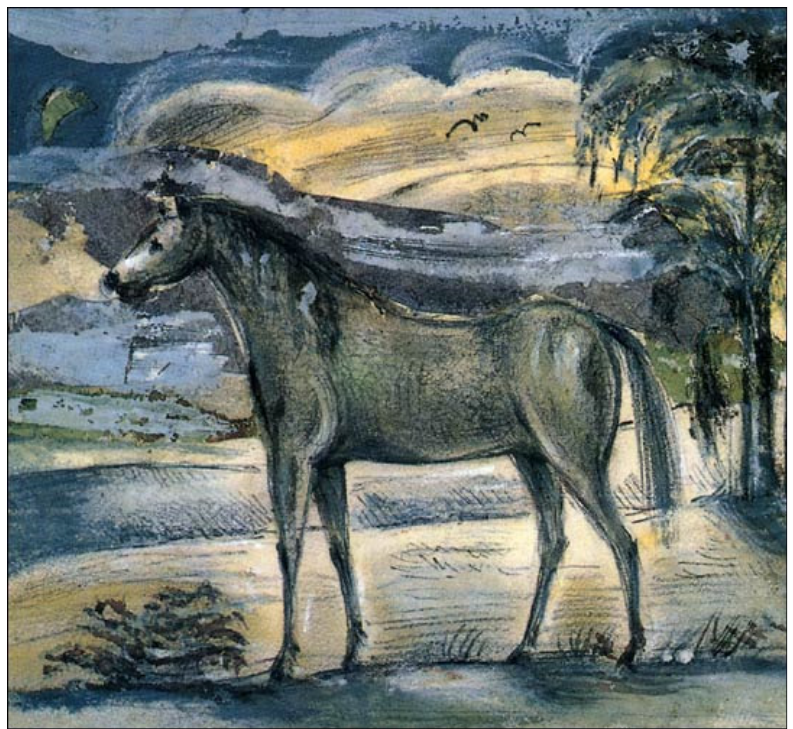
Figure 35. Konstantin Batiushkov. A Horse , 1828 (?). State Literary Museum, Moscow.